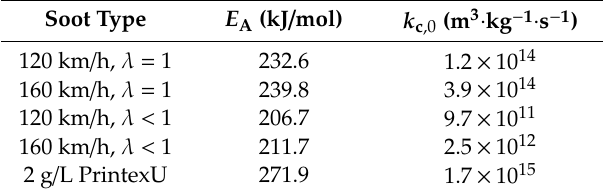
Table 1. Activation energy and pre-exponential factor of di ff erent soot types.